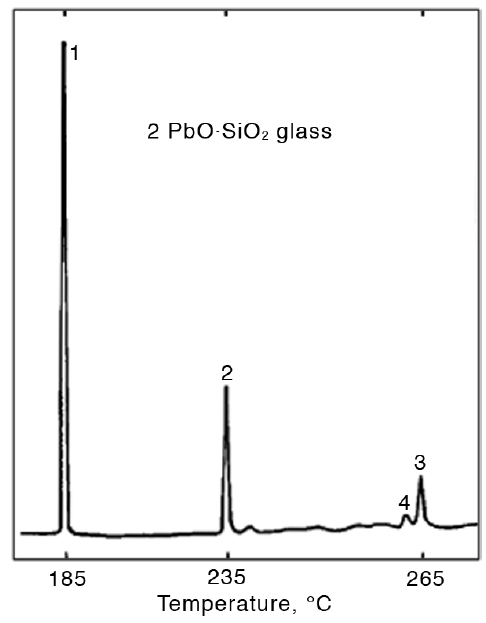
Fig. 2. Distribution of polymers in Pb 2 SiO 4 glass obtained by trimethyl sliylation gas liquid chro- matography of quenched glass. Temperatures refer to chromatographic separation. Peaks 1-4 represent SiO 4 momomers, Si 2 O 7 dimers, Si 3 O 9 rings and Si 4 O 12 rings respectively (after Masson,